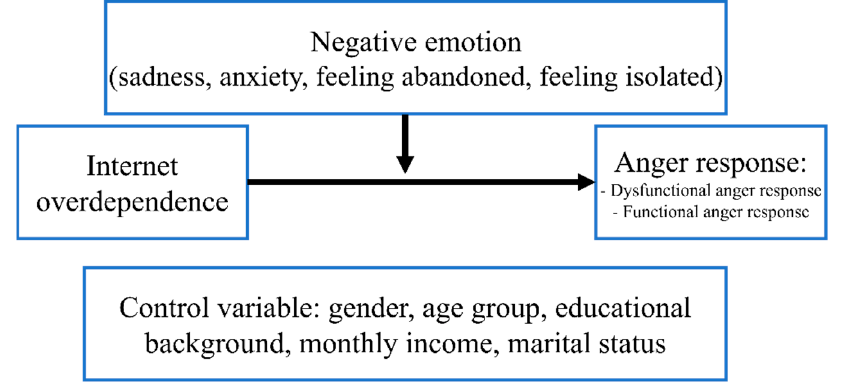
Figure 1. Study model.